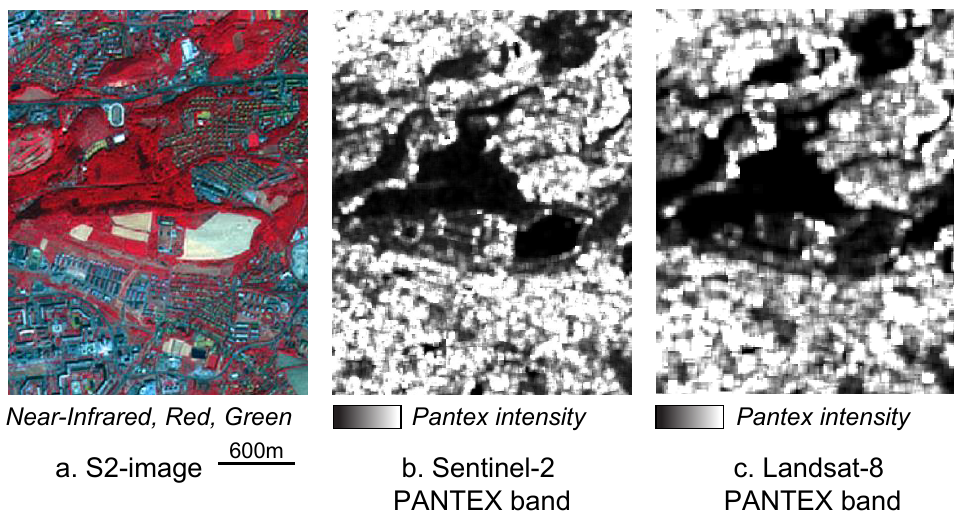
Figure 8. Comparison of S2and L8PANTEX bands: ( a ) subset of Sentinel-2 image; ( b ) Sentinel-2’s PANTEX band; ( c ) Landsat-8’s PANTEX